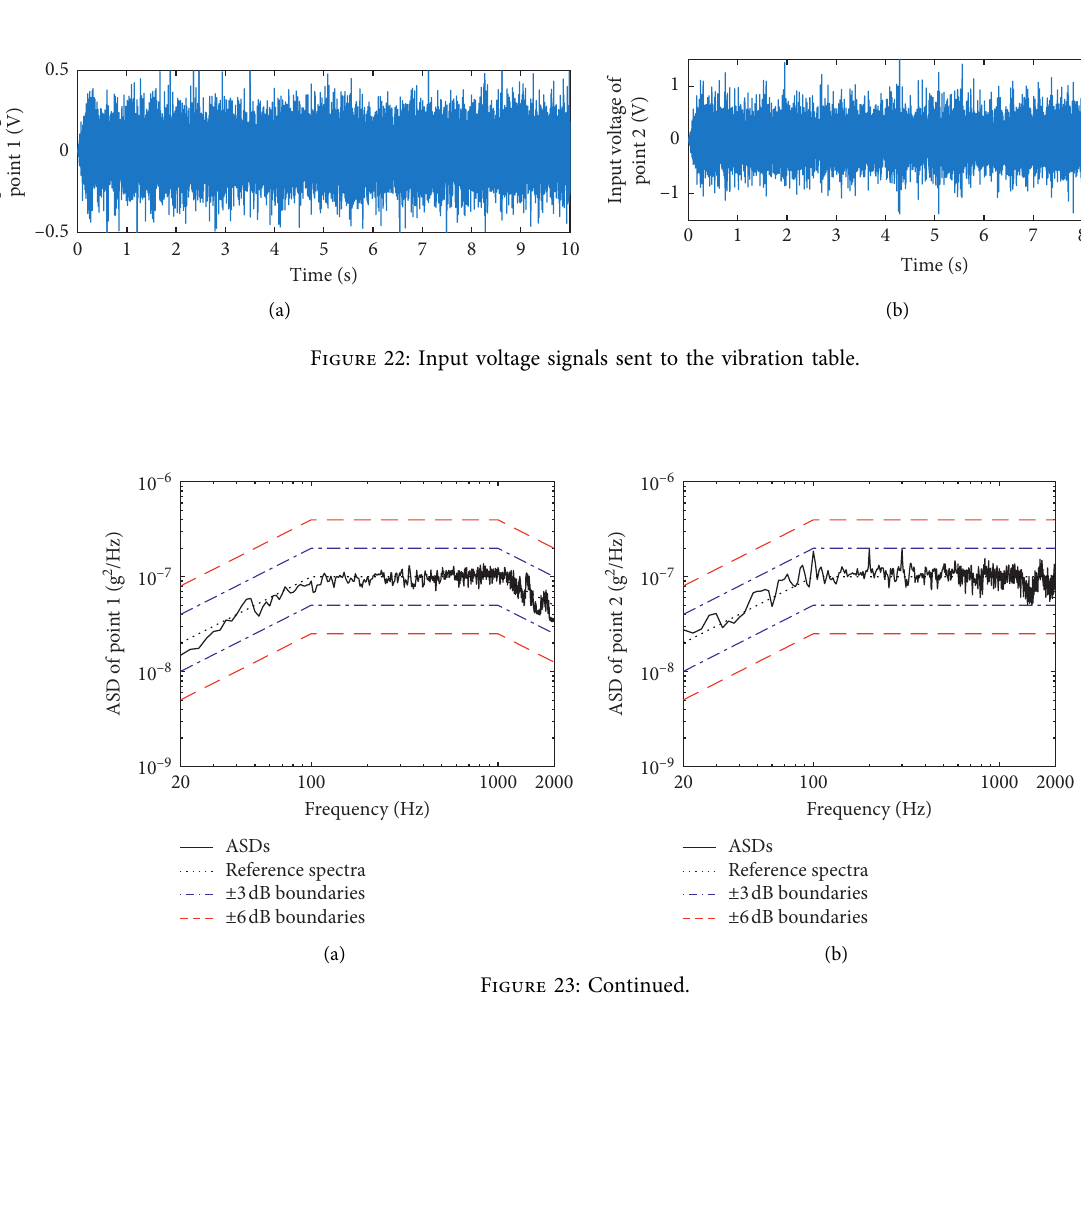
Figure 21: Response kurtoses when the windowed ZMNL transformation and WOA method are both applied.